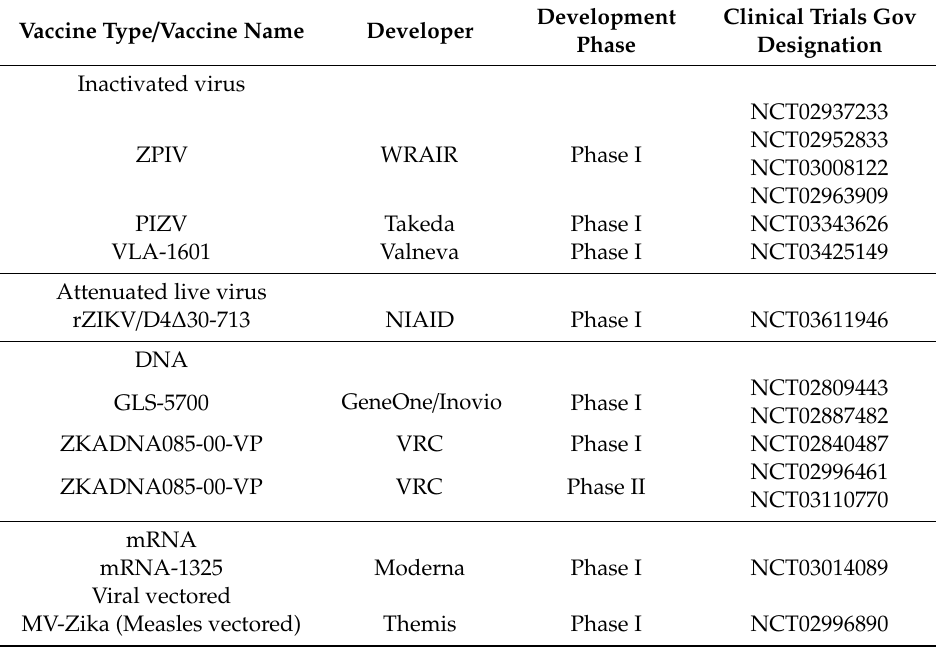
Table 1. Zika vaccines in clinical